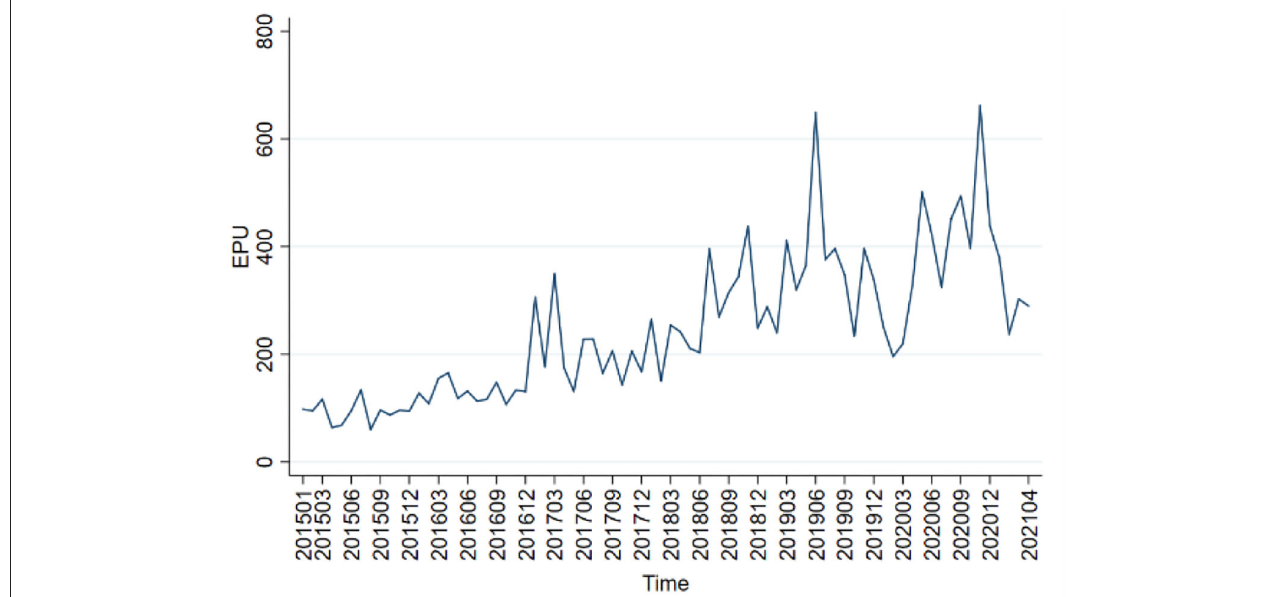
FIGURE 3 | EPU trend chart.